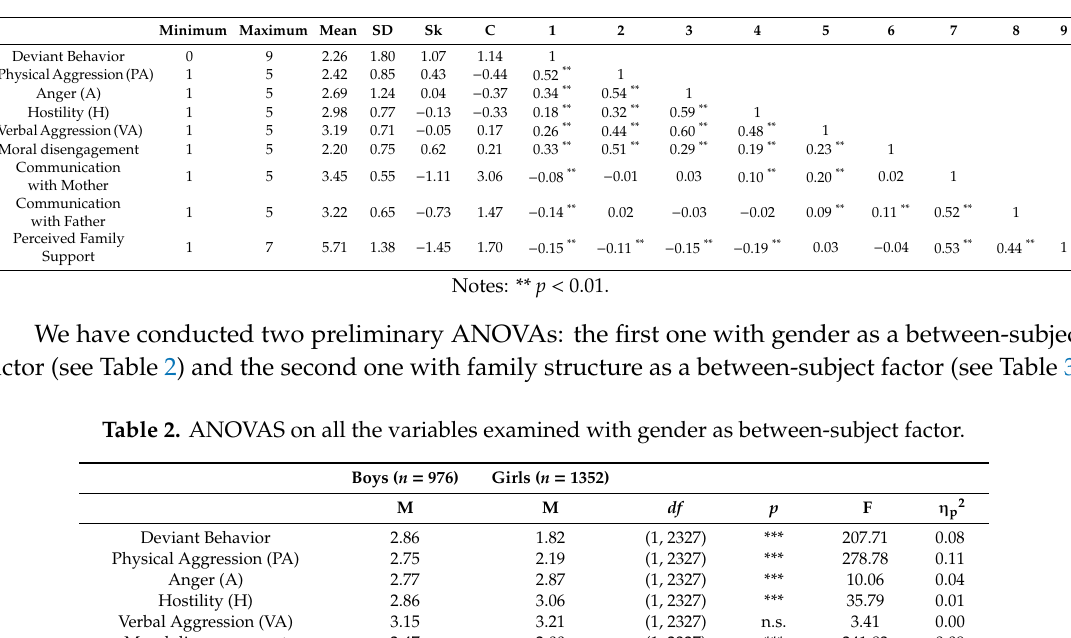
Table 1. Means, standard deviations, alphas, skewness, kurtosis and zero-order correlations between variables ( n = 2328).